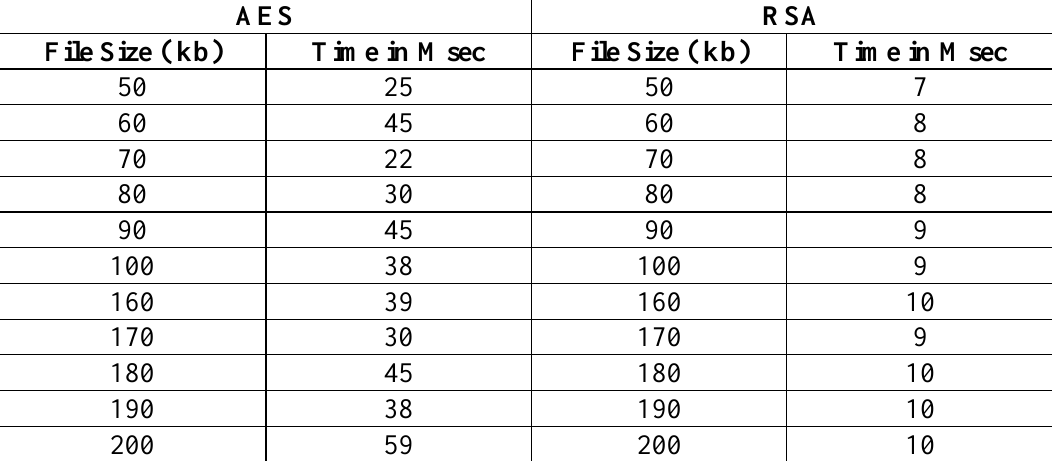
Table 2. Encryption Execution Time of AES and